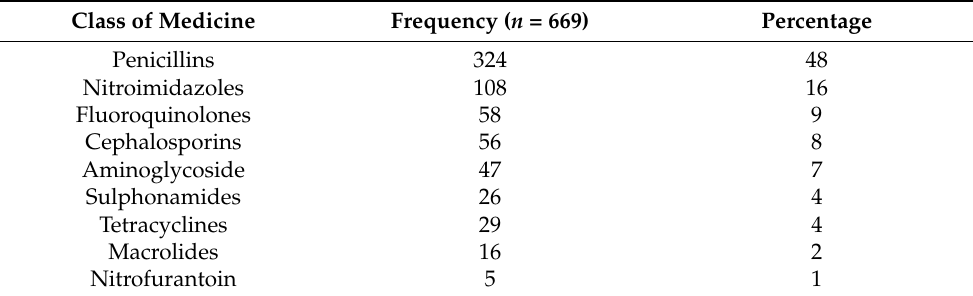
Table 2. Showing class of antibiotics prescribed.